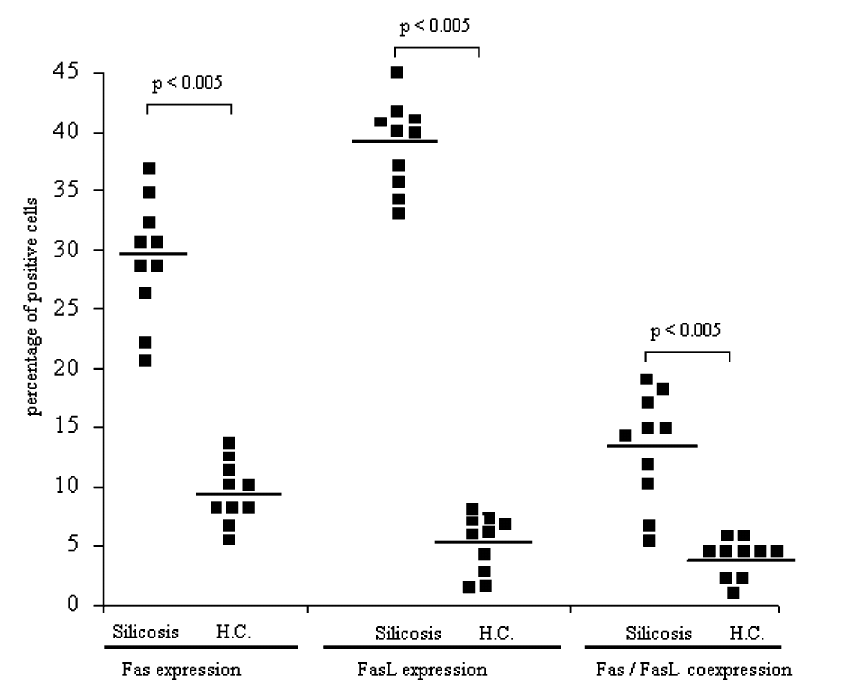
FIG. 1. Expression of Fas and FasL on BAL lymphocytes from silicosis patients and healthy controls (H.C.).